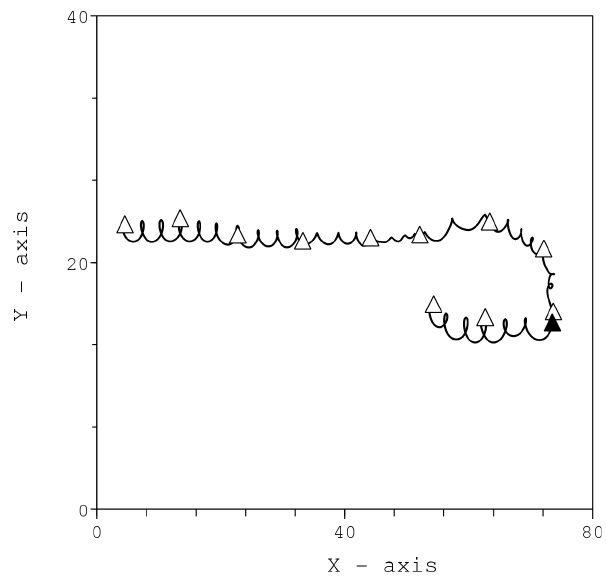
Fig. 10. Orbit of a crossing particle calculated self-consistently.